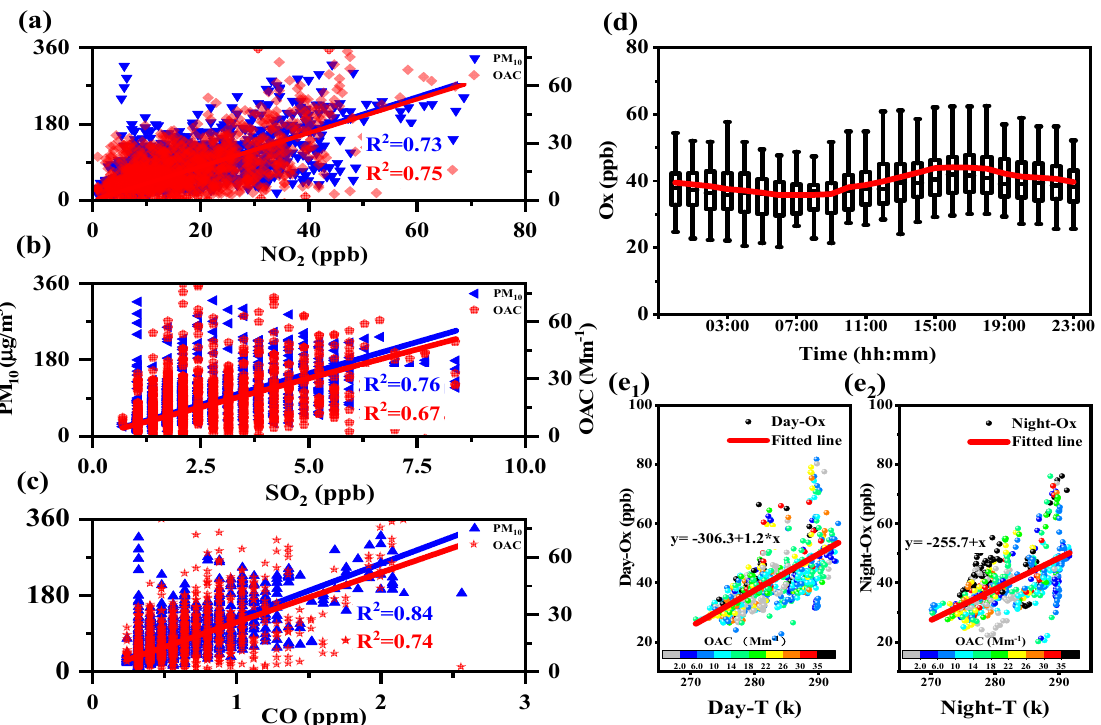
Figure 8. ( a – c ) Linear correlation between gaseous pollutants (SO 2 , NO 2 and CO) and PM 2.5 /OAC. ( d ) Diurnal variation of Ox concentration. ( e 1 , e 2 ) Linear correlation between temperature and O X .